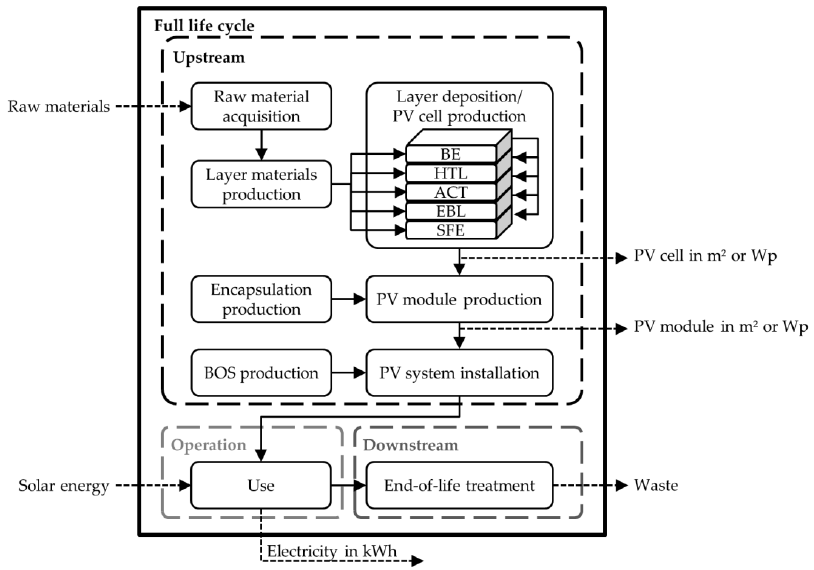
Figure 1. Conceptual life cycle of emerging photovoltaic technologies (PVs) with the technological components and methodological elements such as life-cycle stages, processes, functional units, and input/output flows.